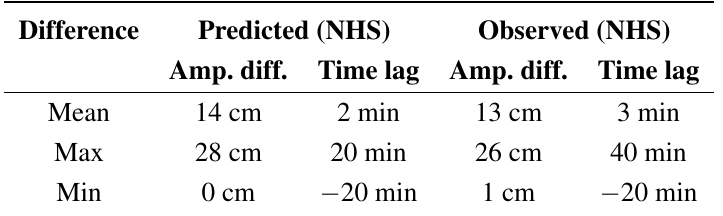
Table 5. Difference in tidal range [amplitude difference (amp. diff.)] and time lag between tidal data received from the NHS (observed and predicted) to measured data from the ADCP (measurement #1) in Skarpsundet.